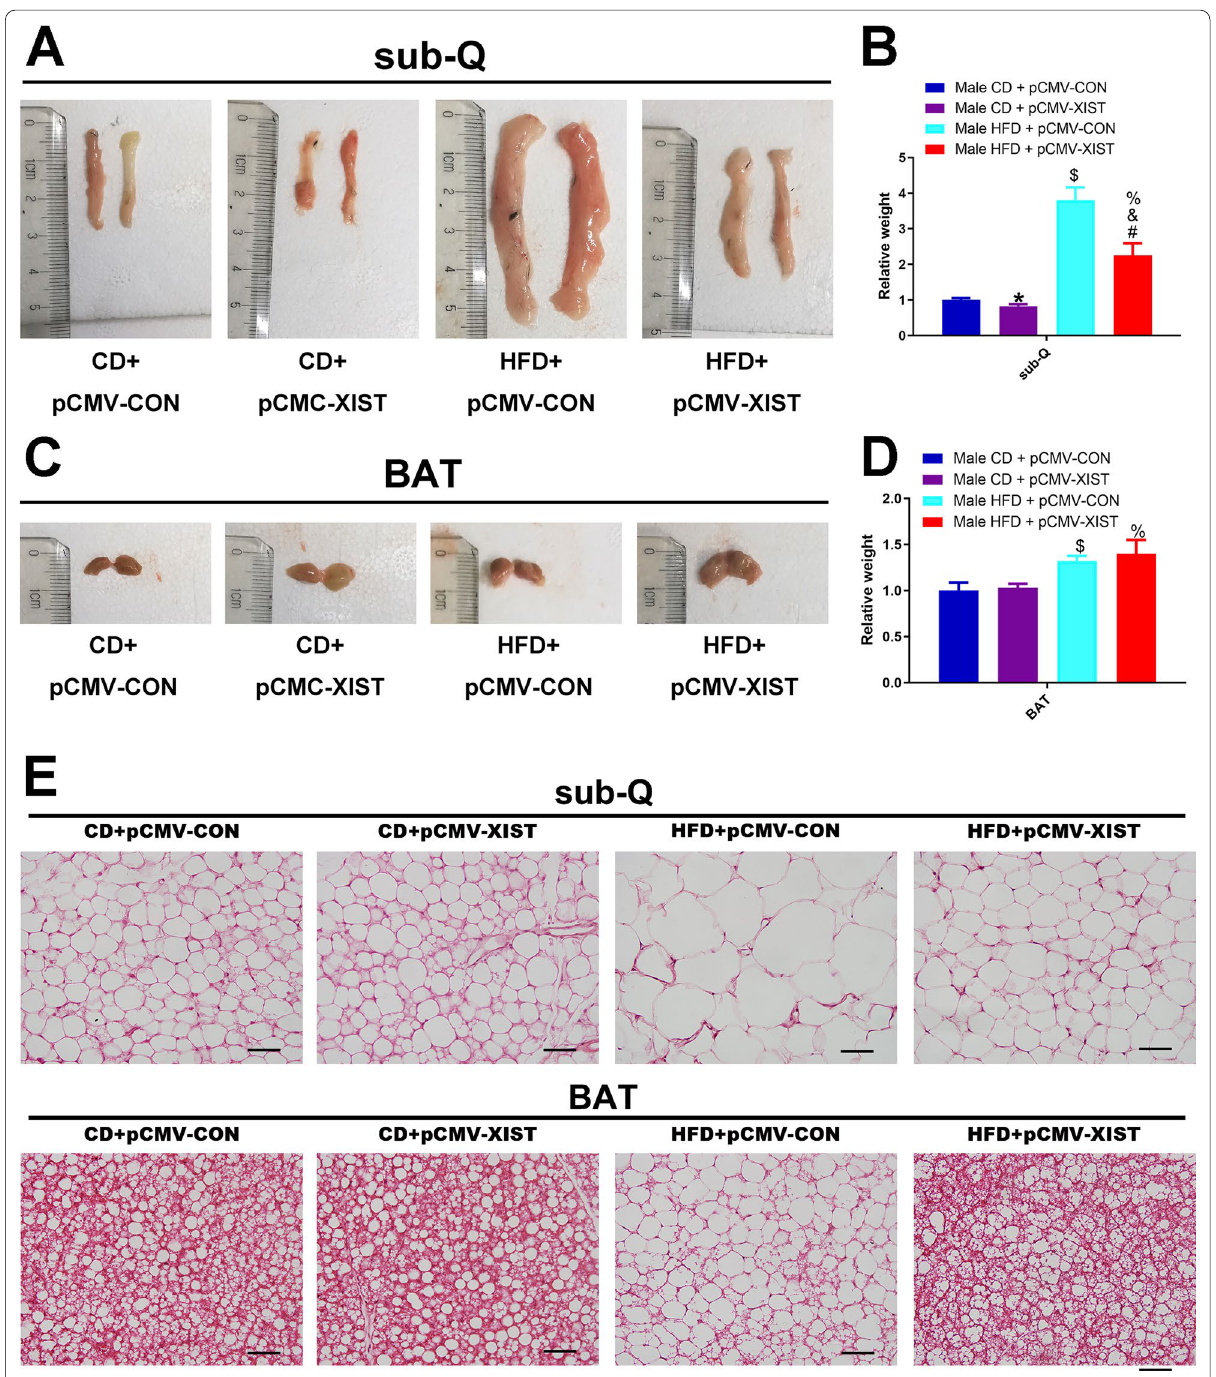
Fig. 5 XIST overexpression attenuates adipose tissue histological changes in HFD-induced mice. A – D Tissue weight in male mice between groups. * vs CD pCMV-CON, p < 0.05; # vs HFD pCMV-CON, p < 0.05; $ vs CD pCMV-CON, p < 0.05; & vs CD pCMV-XIST p < 0.05; % vs CD pCMV-CON, + + + + + p < 0.05. E Representative HE stained subcutaneous and brown adipose tissue of male mice between groups. Scale bar, 50